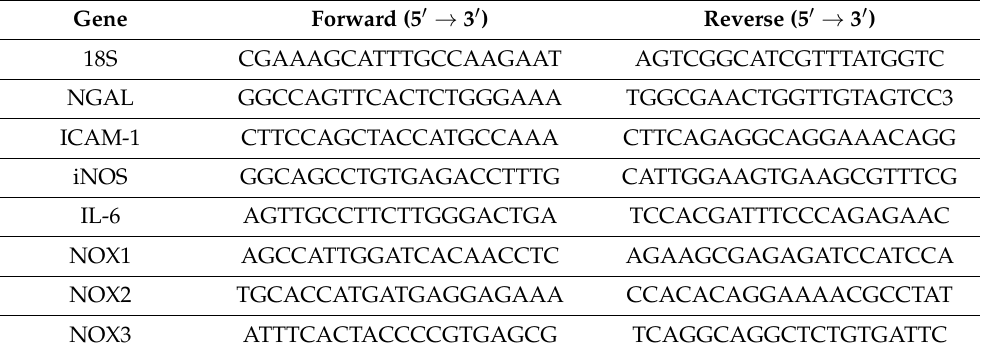
Table 1. Primer sequences used for real time RT-PCR